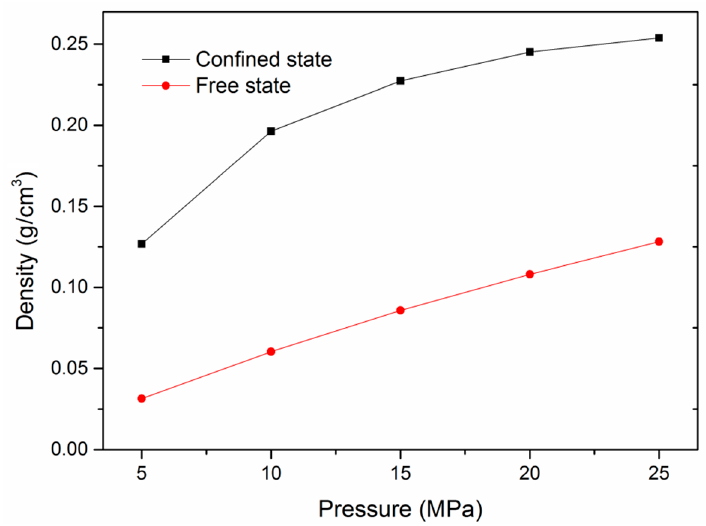
Figure 11. Comparison of density between the confined state and the free state of pure CH 4 as a function of pressure in a slit kerogen nanopore with a pore size of 2 nm (T = 298 K). function of pressure in a slit kerogen nanopore with a pore size of 2 nm (T